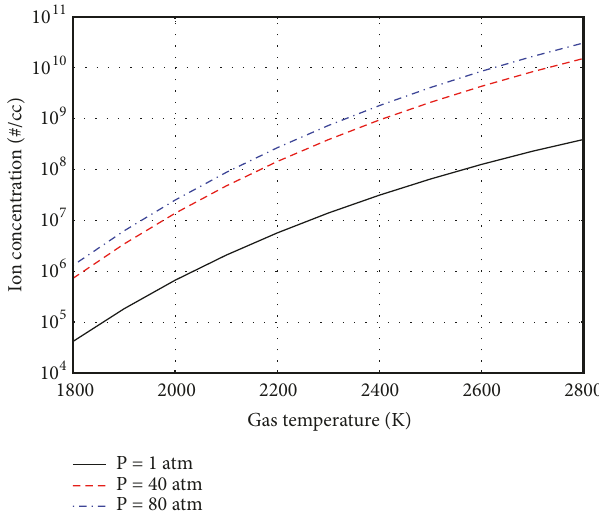
Figure 5: Effect of gas temperature on H 3 O + ion concentration for P = 1, 40 and 80 atm under conditions of thermal equilibrium (T T ) in a stoichiometric propane-air g